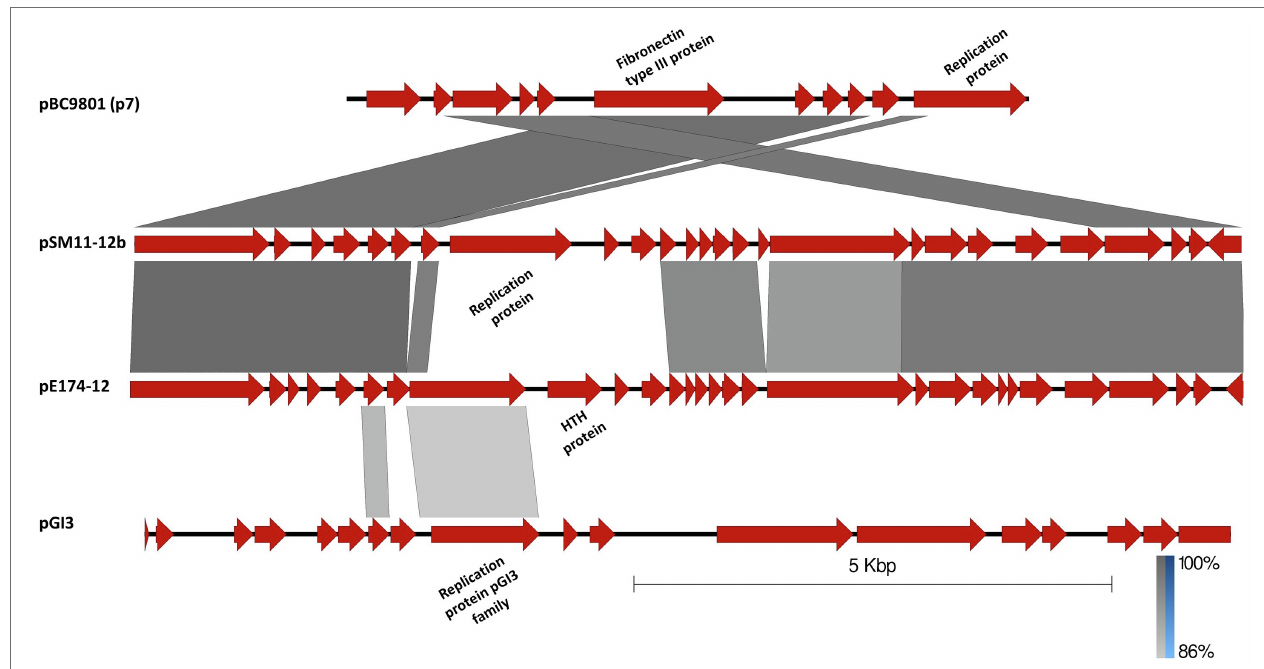
FIGURE 3 | Linear alignment of pBC9801 (also referred to as the 7-kb plasmid in Stevens et al., 2019), pSM11-12b, pE174-12 from B. cytotoxicus, and pGI3 from B. thuringiensis strain H1.1 (Hoflack et al., 1997; NC_010937.1). CDSs are represented by block arrows. Relevant functions are annotated above or below the corresponding gene. Darkening gray shading reflects increasing nucleotide BLAST sequence identity. Scale and identity percentage are indicated in the lower right- hand